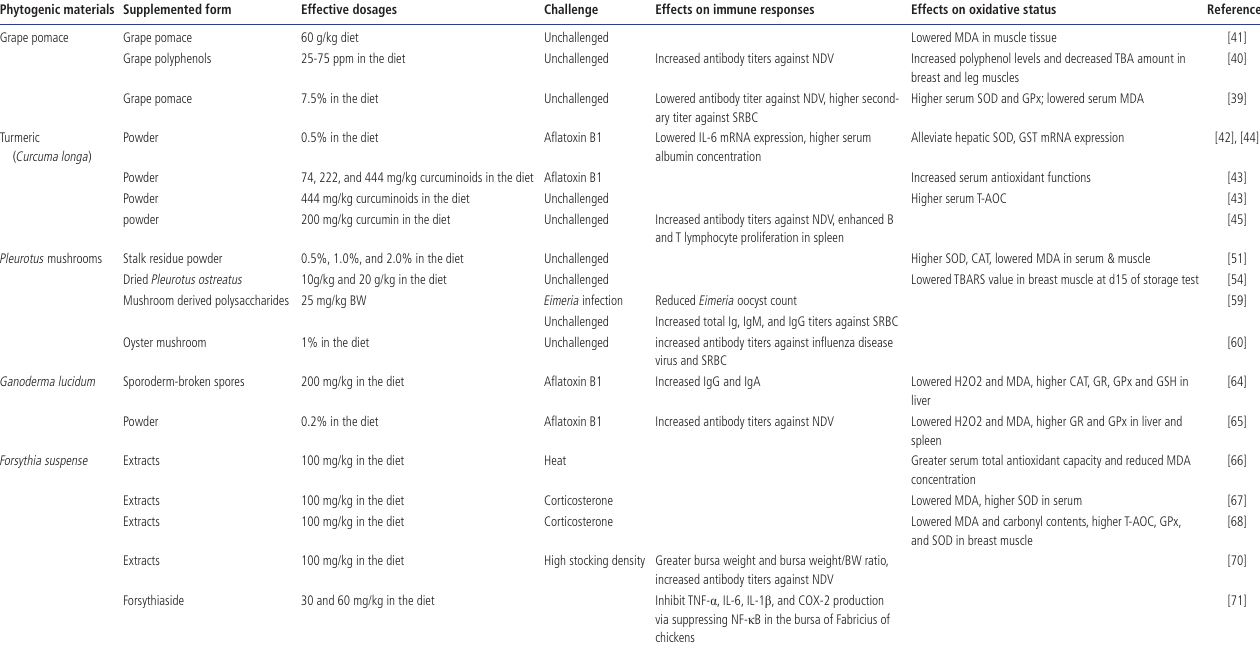
Table 1. Amelioration effects of phytochemicals on oxidative status and immune responses in poultry Phytogenic materials Supplemented